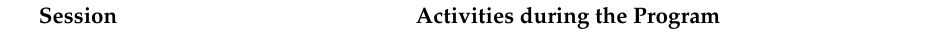
Table 3. Details of the Play&Grow intervention, the detailed description of the relevant theories can be seen in